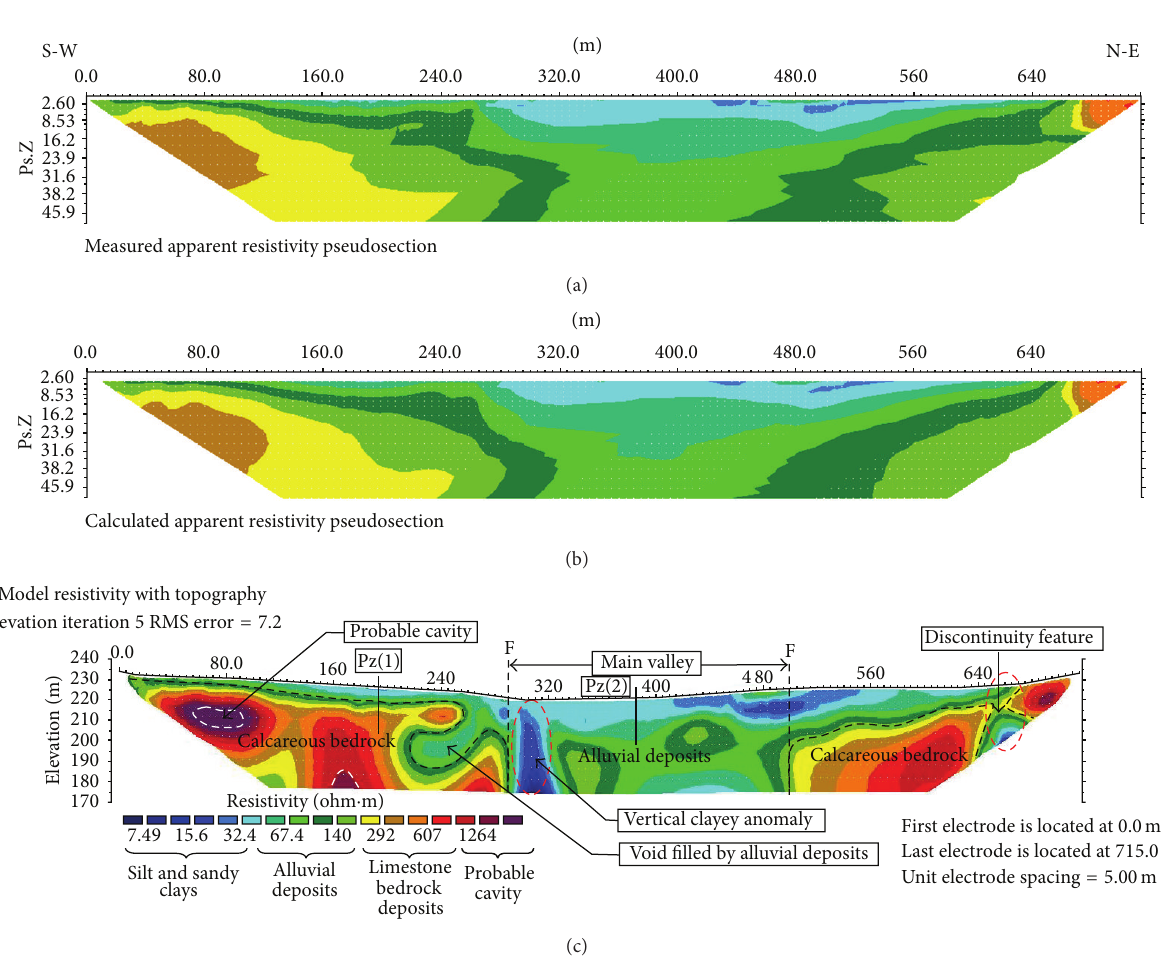
Figure 4: Interpretation of the geoelectrical section of the ERT-P1 profile carried out in downstream of Abu Baara dam: (a) pseudosection of the measured apparent resistivity, (b) pseudosection of the calculated apparent resistivity, and (c) interpretation of the inverted ERT section with topography; Pz(1) and Pz(2): piezometric boreholes locations drilled behind the dam body.